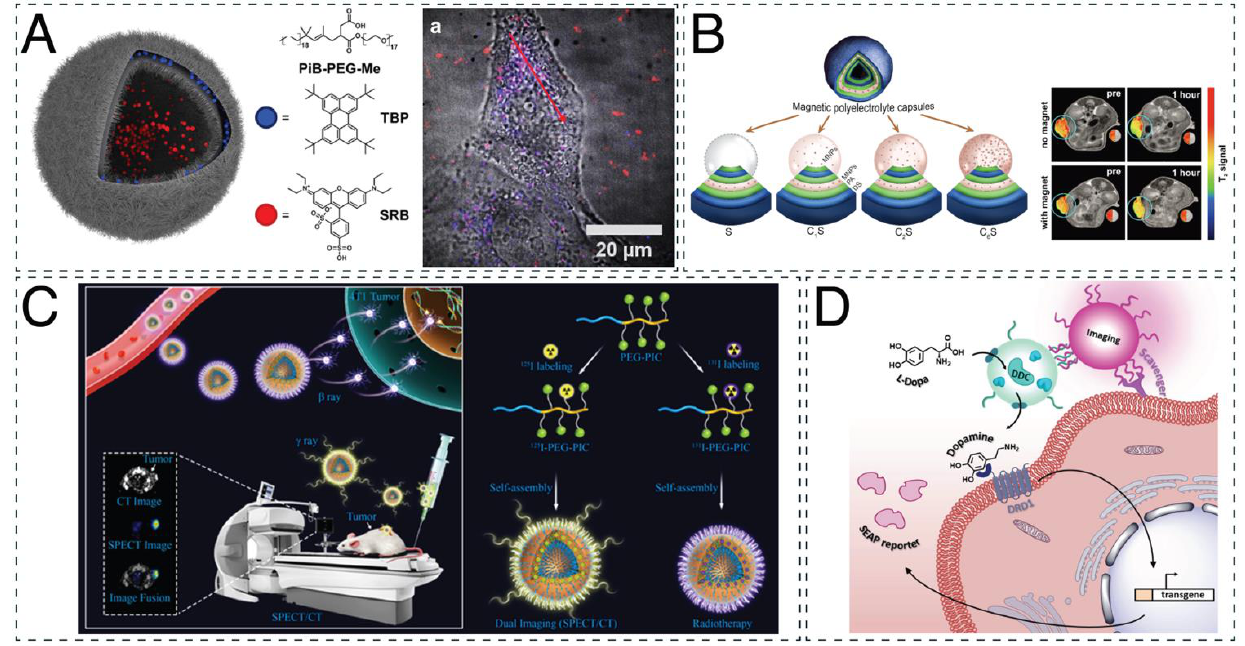
Figure 2. Imaging and theranostic applications of nanocompartments. ( A ) Dual fluorescence of polymersomes for optical imaging. Adapted with permission from [168]. Copyright 2018 Elsevier. ( B ) Magnetic LbL capsules for cancer targeting and treatment by magnetic resonance imaging (MRI). Adapted with permission from [57]. Copyright 2021 Ivyspring International Publisher. ( C ) Radiolabeled iodine-rich polymersomes for single-photon emission computed tomography (SPECT)/computed tomography (CT) dual imaging and cancer therapy. Reprinted with permission from [170]. Copyright 2019 American Chemical Society. ( D ) Theranostic DNA-zipped polymersome clusters composed of two nanocompartments: a therapeutic, dopa decarboxylase (DDC)-containing polymersome and an imaging, DY-633-containing polymersome. Reprinted with permission from [103]. Copyright 2020 John Wiley and